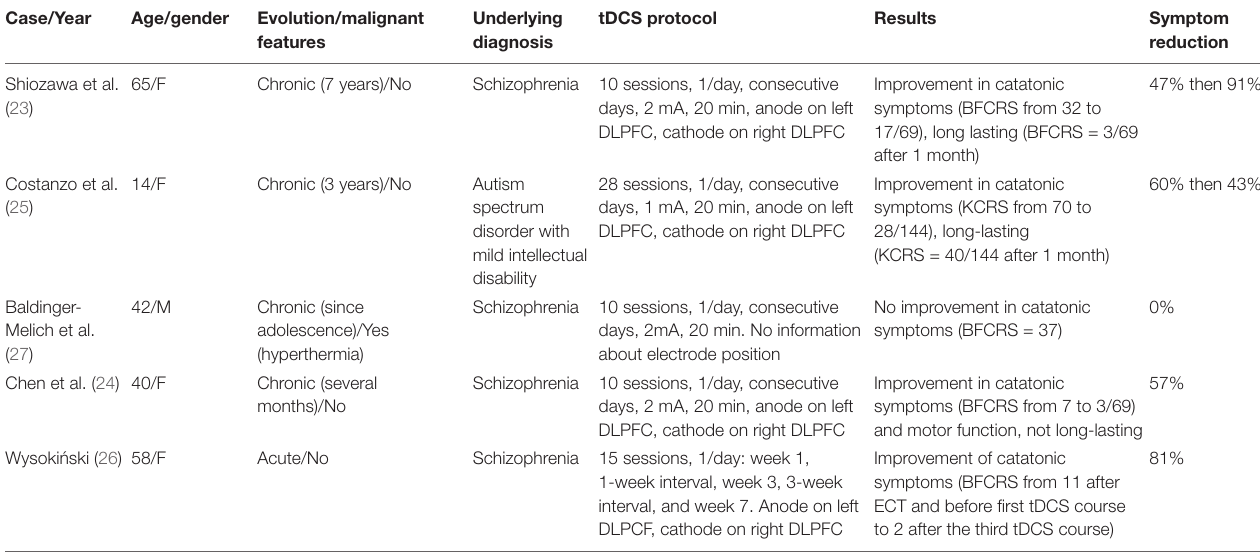
TABLE 1 | Published case reports of catatonia treated with direct transcranial direct stimulation